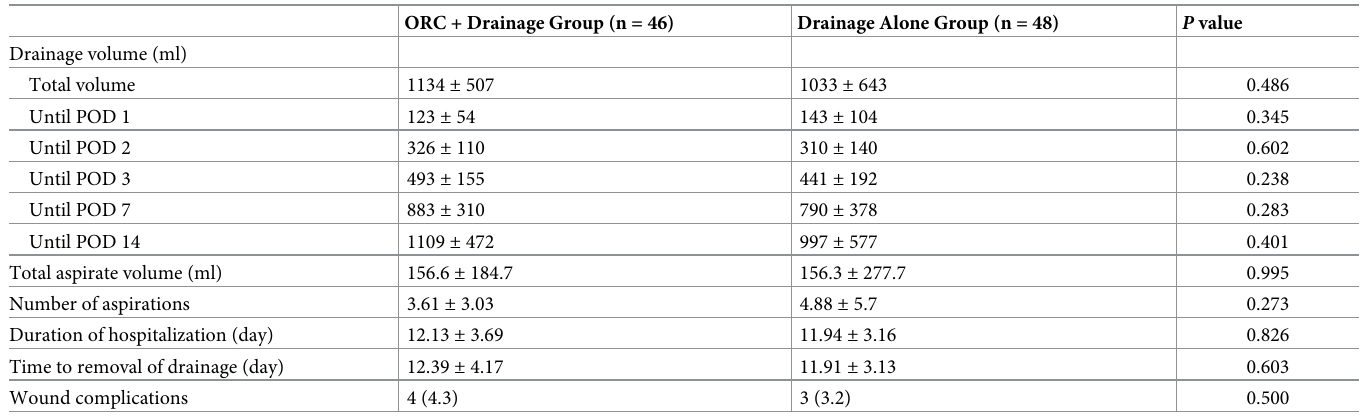
Table 2. Comparison of postoperative outcomes in two groups.